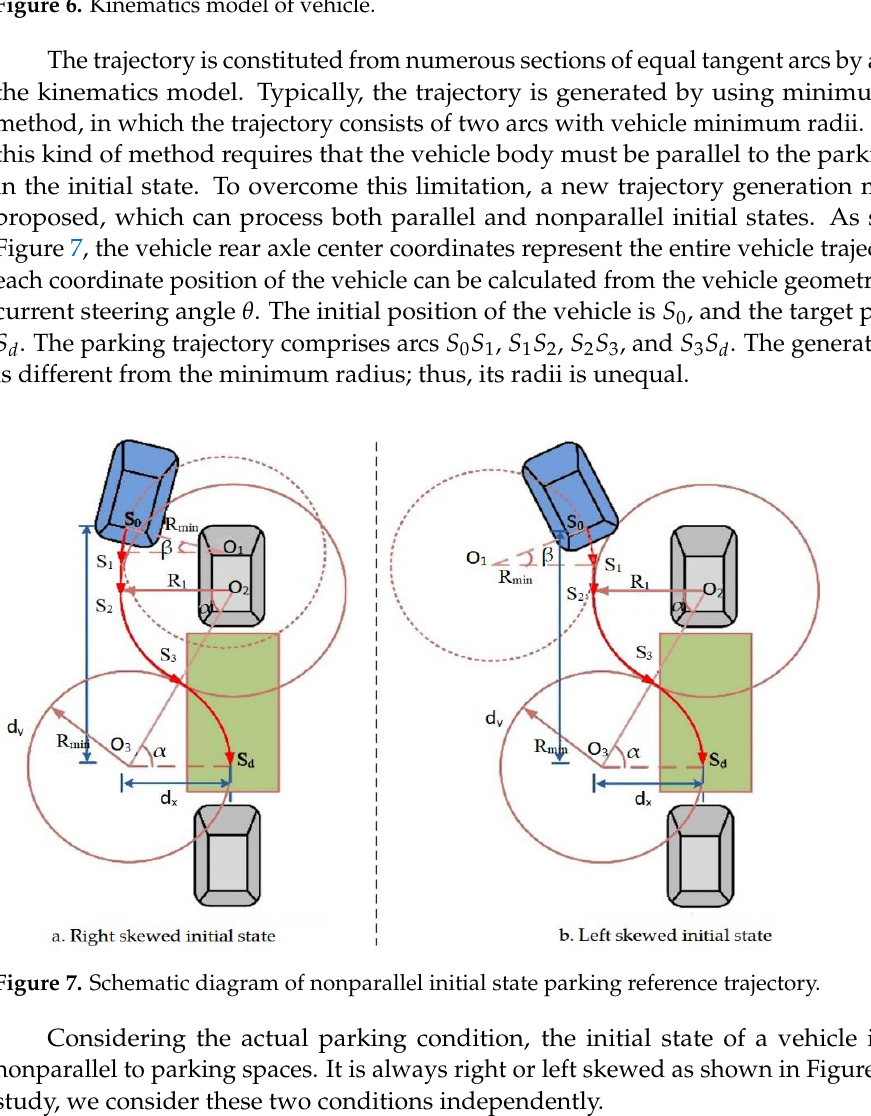
Figure 7. Schematic diagram of nonparallel initial state parking reference trajectory. Considering the actual parking condition, the initial state of a vehicle is always nonparallel to parking spaces. It is always right or left skewed as shown in Figure 7. In our study, we consider these two conditions independently. In the right skewed condition, as shown in Figure 7a, the car firstly turns left with center point O 1 , and its radius is R min . When the rear axle center point reaches point S 1 , the car moves straight up to point S 2 . The car then turns right with center point O 1 , and the corresponding radius is R 1 . It maintains this state until arriving at point S 3 . Finally, the car turns left with center point O 2 until reaching point S d , and its radius is R min . From